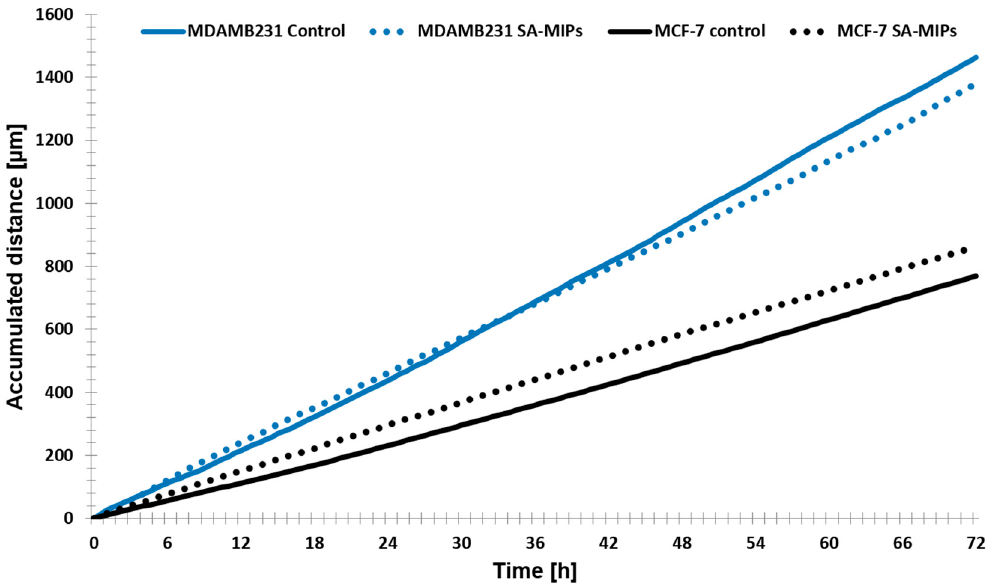
Figure 2. Motility diagram presenting the accumulated distance in µm for the untreated and treated MCF-7 cells and MDAMB231 cells with 0.04 mg/mL of SA-MIPs incubated over time. The holograms were captured every 30 min for 72 h. The experiment is repeated at least three times with similar results. The diagram show results from one representative experiment.